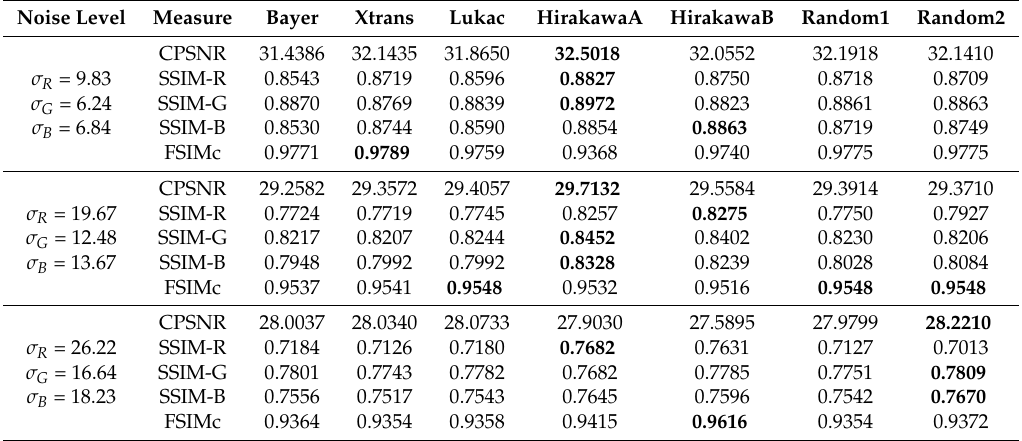
Table 1. Comparison of the CPSNR, SSIM and FSIMc values for the different CFA patterns used with the proposed method on the Kodak image